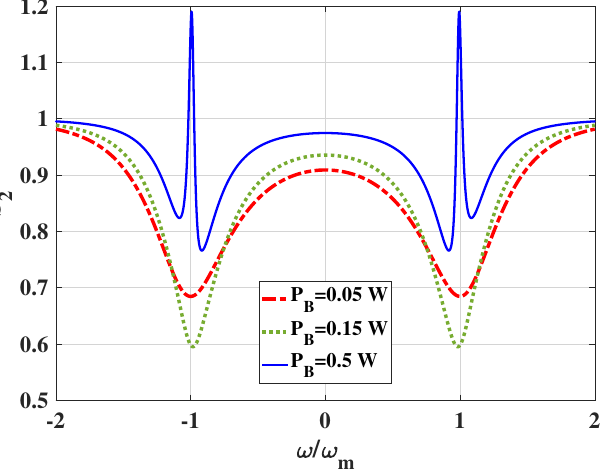
Figure 7. S 2 ( ω ) as a function of P B . The power of optical tweezer A in focus is set to P A = 0.1 W. Tweezer A is detuned to the red sideband while tweezer B is set to be the blue sideband. Other parameters are the same as Figure